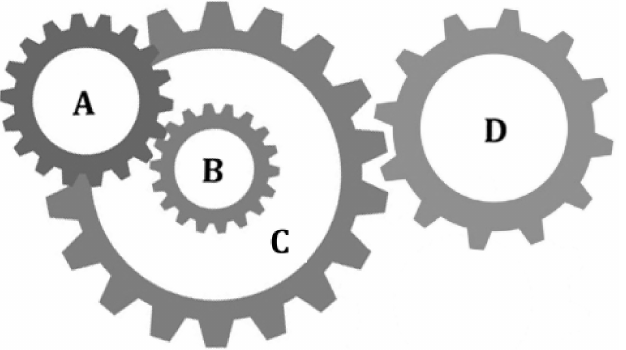
Figure 9. Gear train